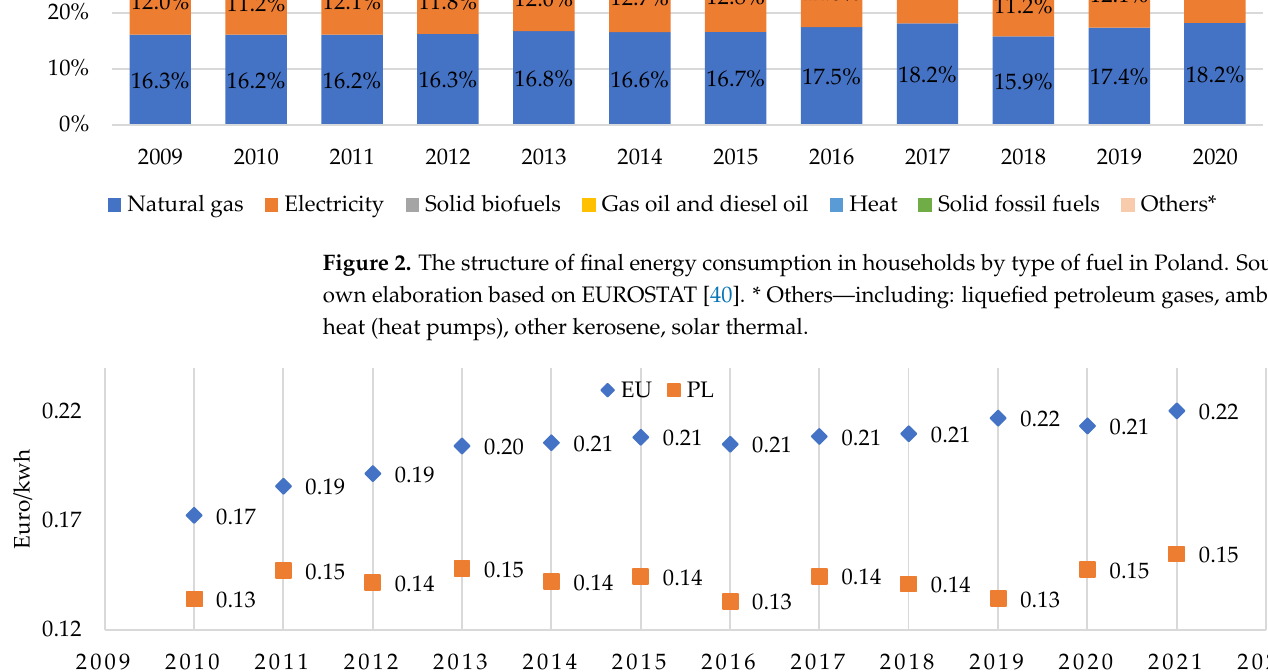
Figure 2. The structure of final energy consumption in households by type of fuel in Poland. Source: own elaboration based on EUROSTAT [40]. * Others — including: liquefied petroleum gases, ambi-